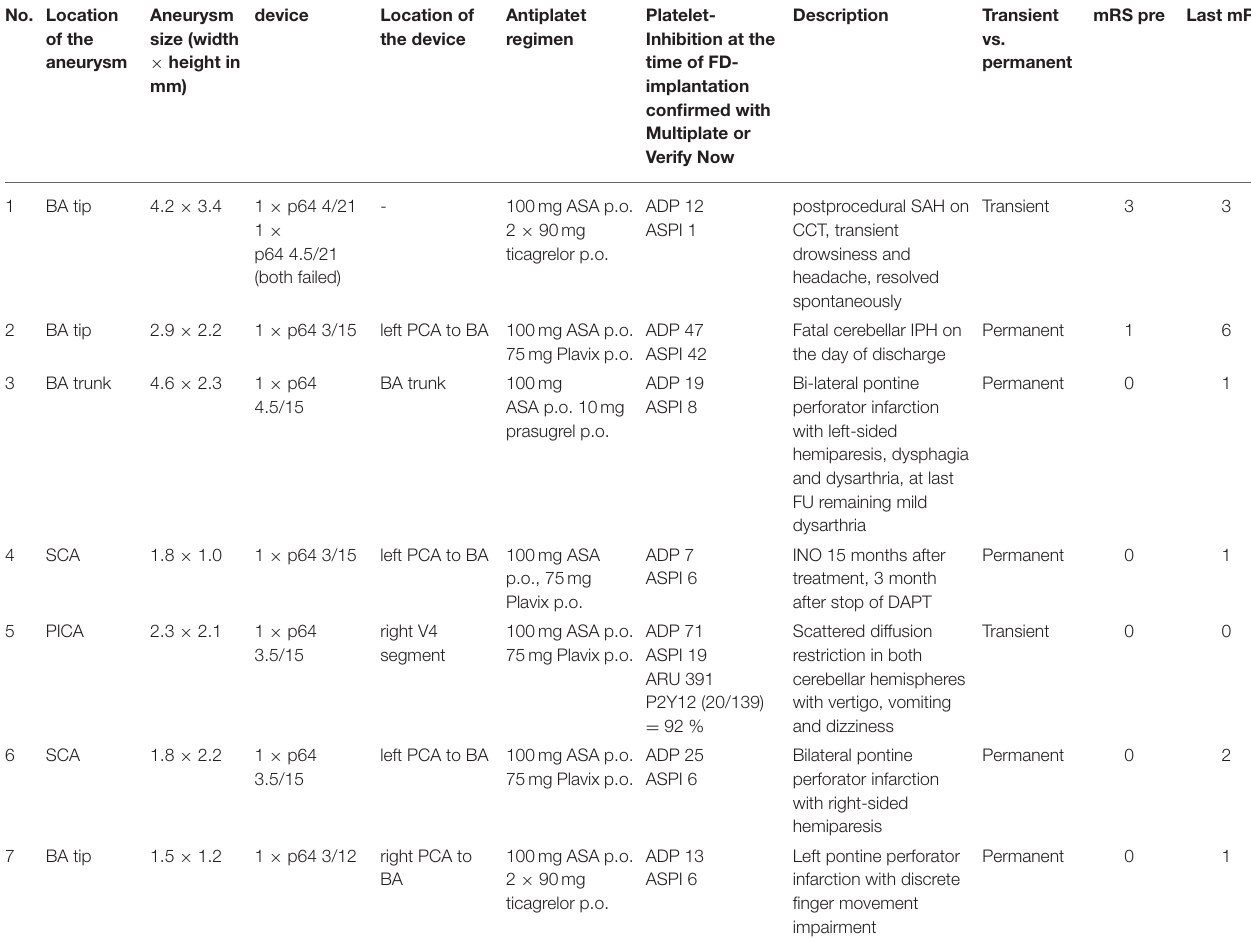
TABLE 5 | Clinically relevant complications